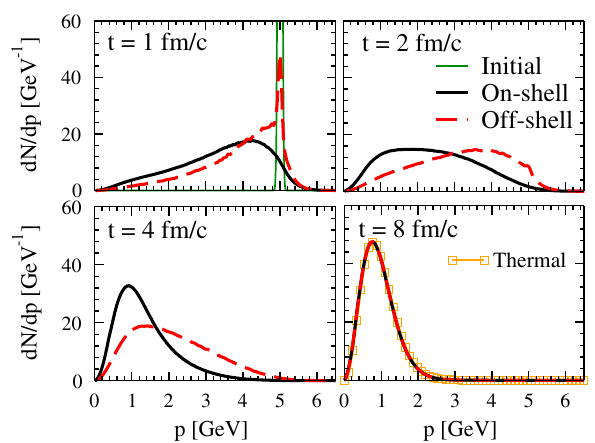
Fig. 11 Charm quark momentum distribution as a function of the charm quark momentum at four different times t = 1 f m / c (left upper panel) and t = 2 f m / c (right upper panel), t = 4 f m / c (left lower panel) and t = 8 f m / c (right lower panel). Black solid lines are for on-shell dynamics while red dashed lines are for off-shell dynamics. The solid thin green line is the initial distribution that is the same for both